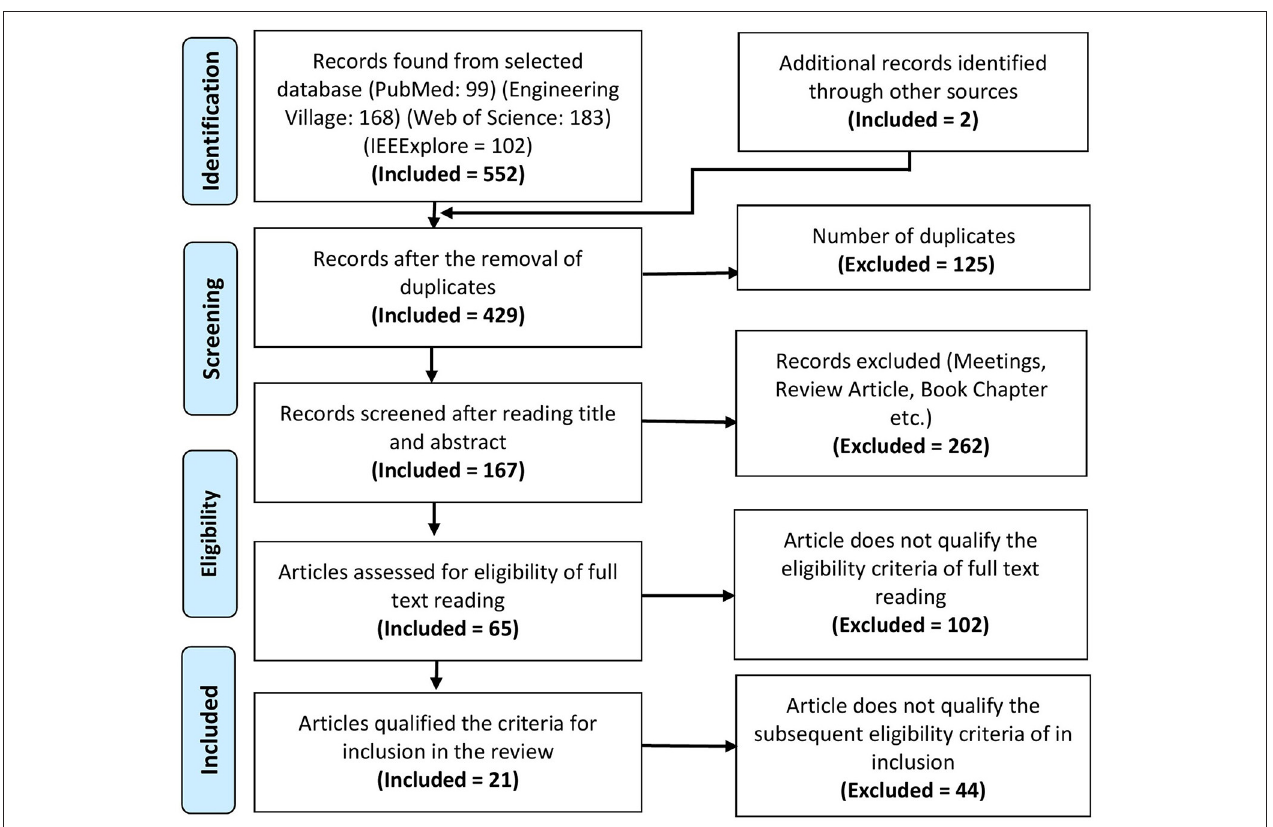
FIGURE 2 | PRISMA flowchart of the article